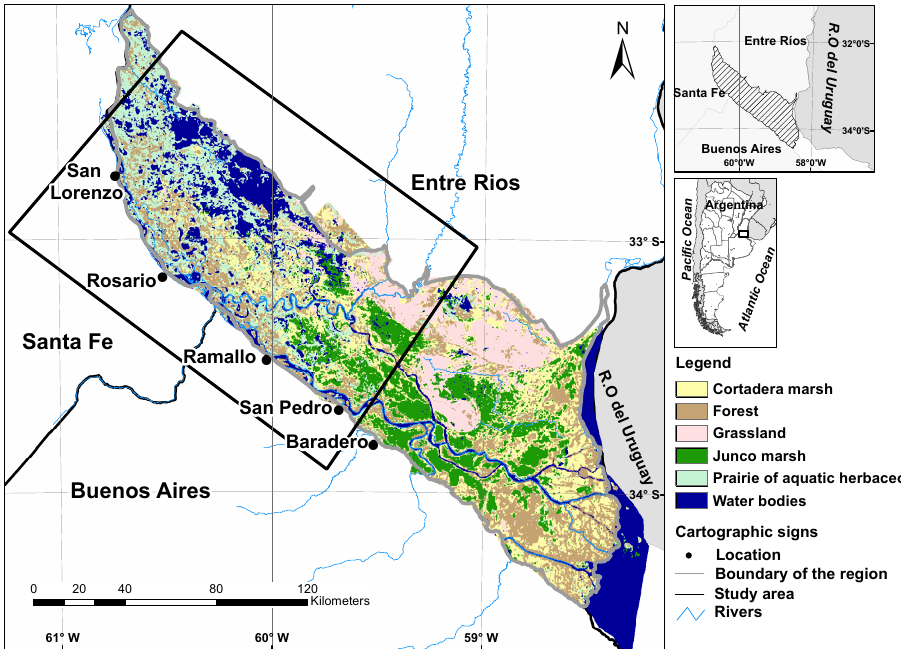
Fig. 1. Landcover map of Paran´a River Delta. Main vegetation patterns mapped using SAC-C MMRS system (Salvia et al., 2009) are shown. The rectangular box indicates the area selected in this study. Table 1. Summary of used